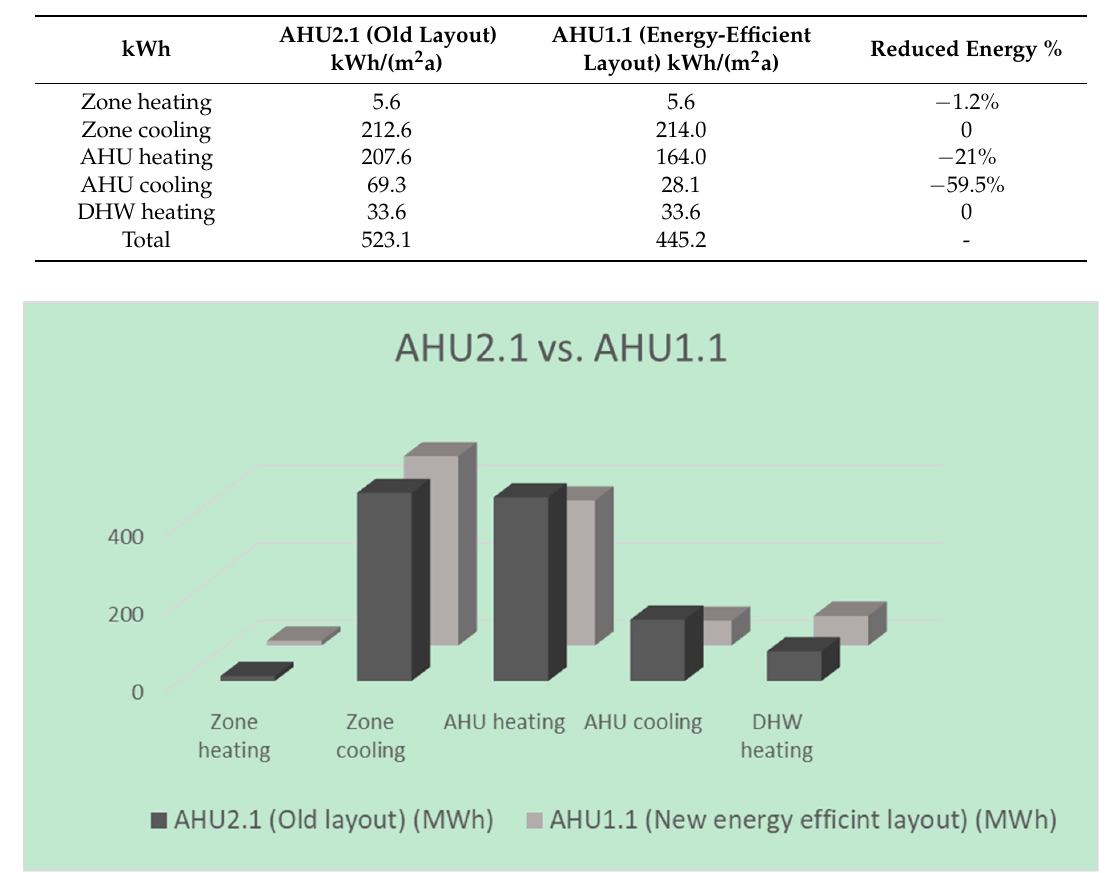
Figure 16. Comparison of cooling and heating energy demands between AHU2.1 and AHU1.1.